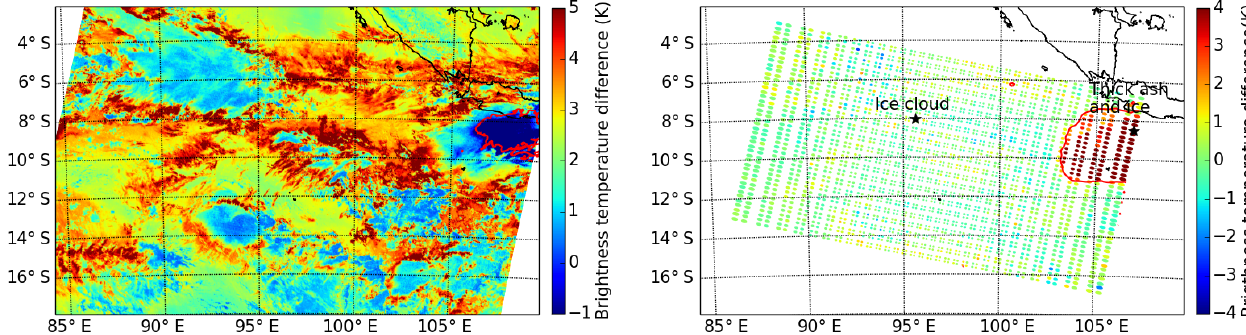
Figure 1. (Left panel) The brightness temperature difference between AVHRR/3 channels 4 and 5 (BTD A = BT 4 − BT 5 ). The contour line (red) is at − 0.5K. (Right panel) The 1231.5–1097.25cm − 1 brightness temperature difference from IASI/MetOp-A spectra. The contour line is at 1.5K. Data from 14 February 2014, 02:53UTC.